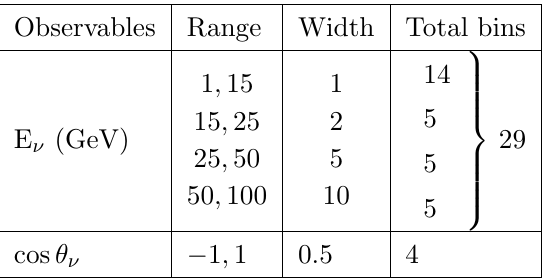
Table 3. The binning scheme adopted for the reconstructed E (cid:23) and cos (cid:18) (cid:23) for each muon polarity. The last column depicts the total number of bins considered for each